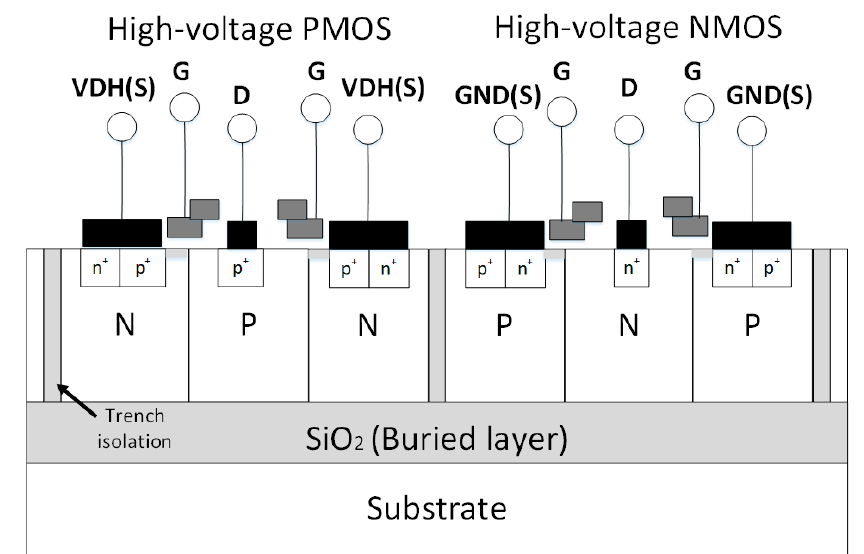
Sensors 2019 , 19 , 5063 Figure 17. The cross-section view of high-voltage (HV) devices in a CMOS-SOI process.